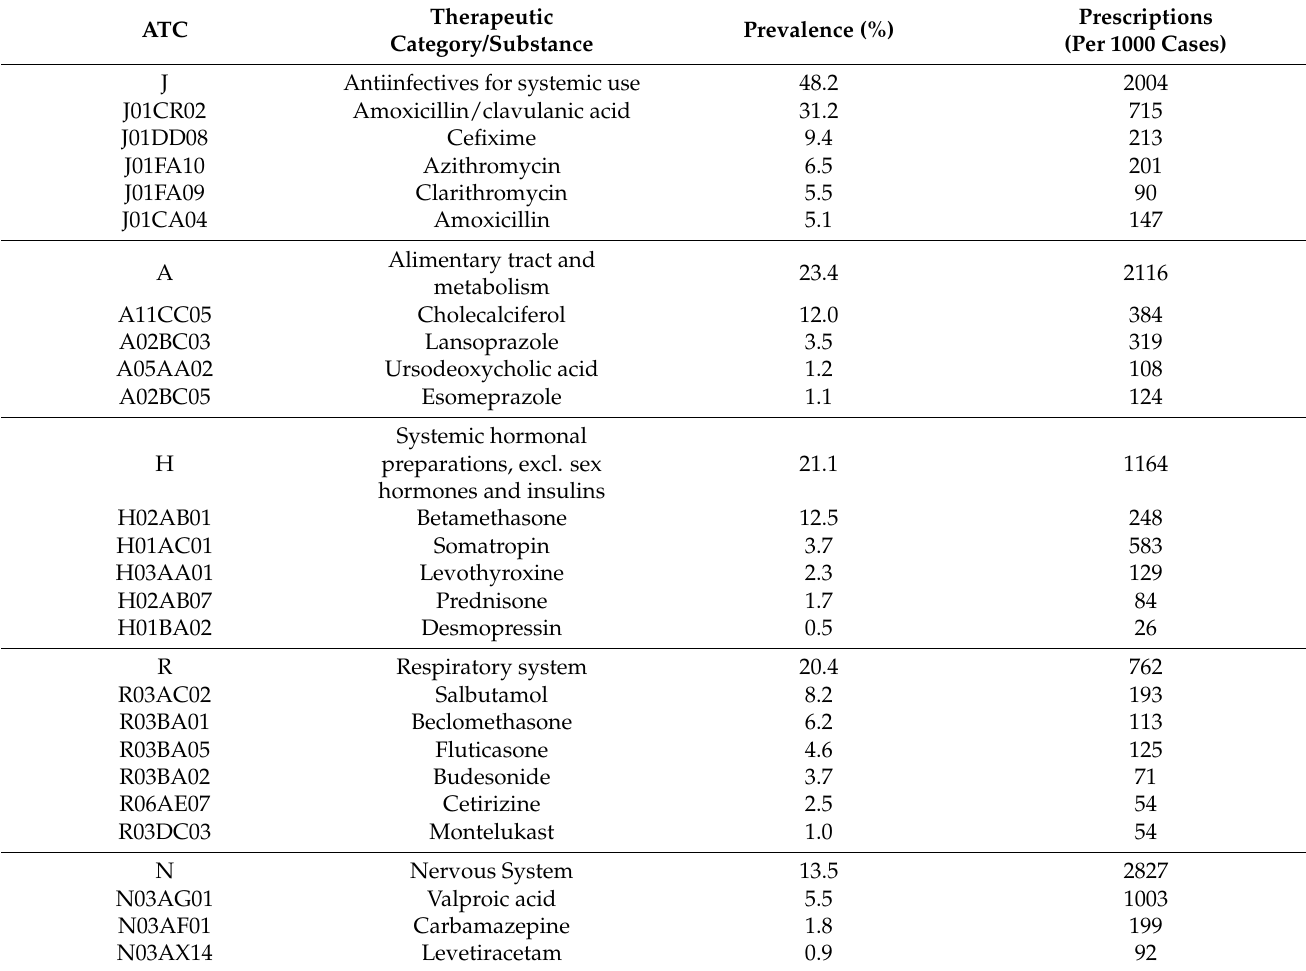
Table 2. The most prescribed substances for RD patients in pediatric age by therapeutic category in the last year of the study period